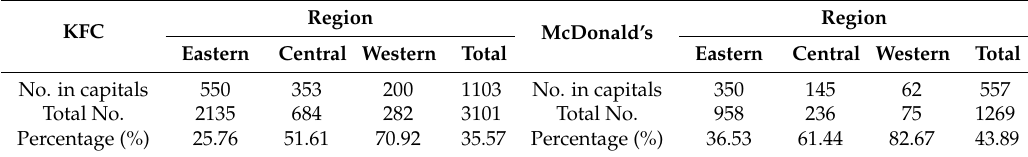
Table 1. The total number and percentage of KFC and McDonald’s outlets in provincial capitals in the three regions.